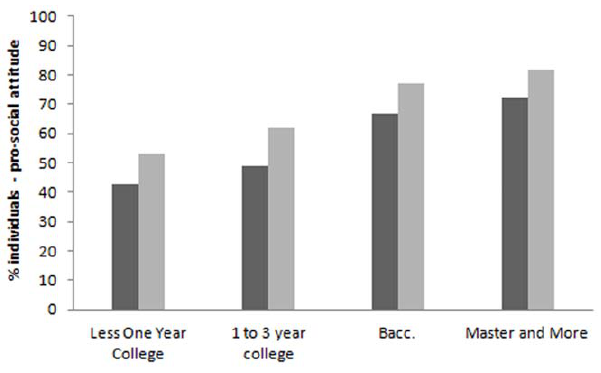
Figure 1. Percentage of men (black bars) and women (grey bars) exhibiting a pro-social attitude, separately for educa- tional category.